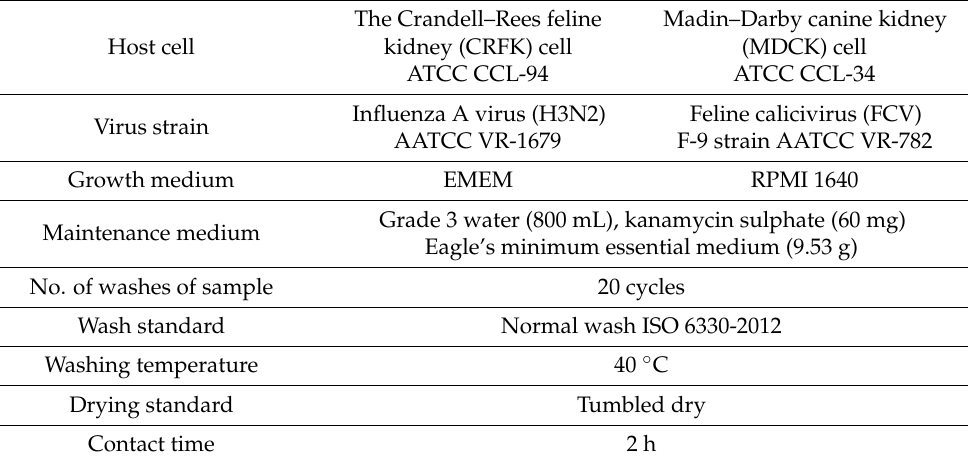
Table 1. Type of material and testing